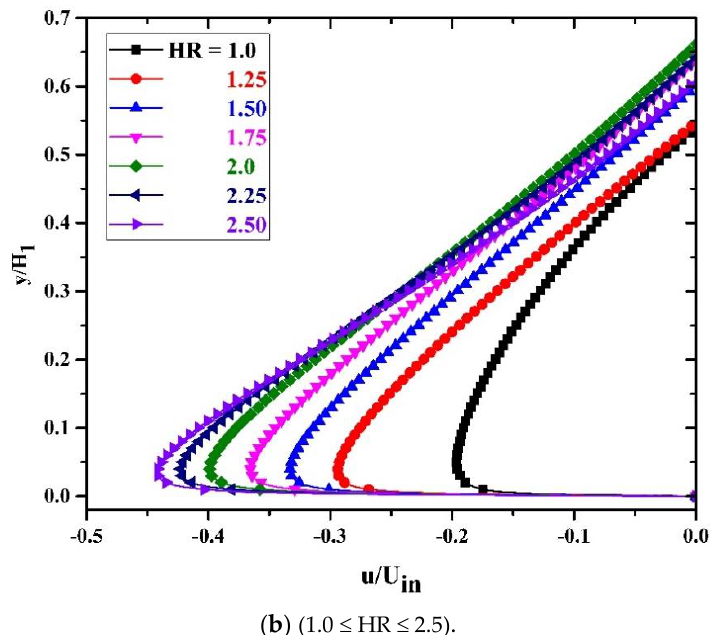
Figure 9. Velocity profiles along a vertical line passes through circulation vortex center for the shallow cavity (AR = 5) at different height ratios.